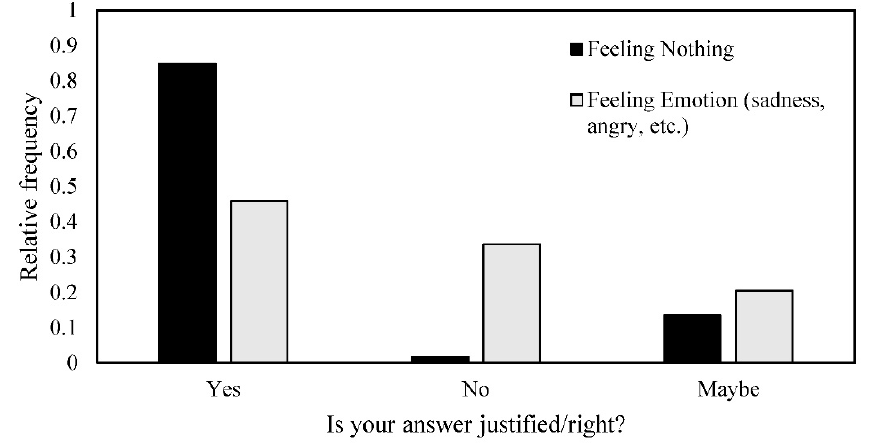
Figure 5. Relative frequency of answers Yes / No / Maybe to the question ‘Do you think that this feeling is justified?’ for participants who said they felt nothing or felt an emotion (sadness, surprise, angry) when the robot was kicked by an engineer.